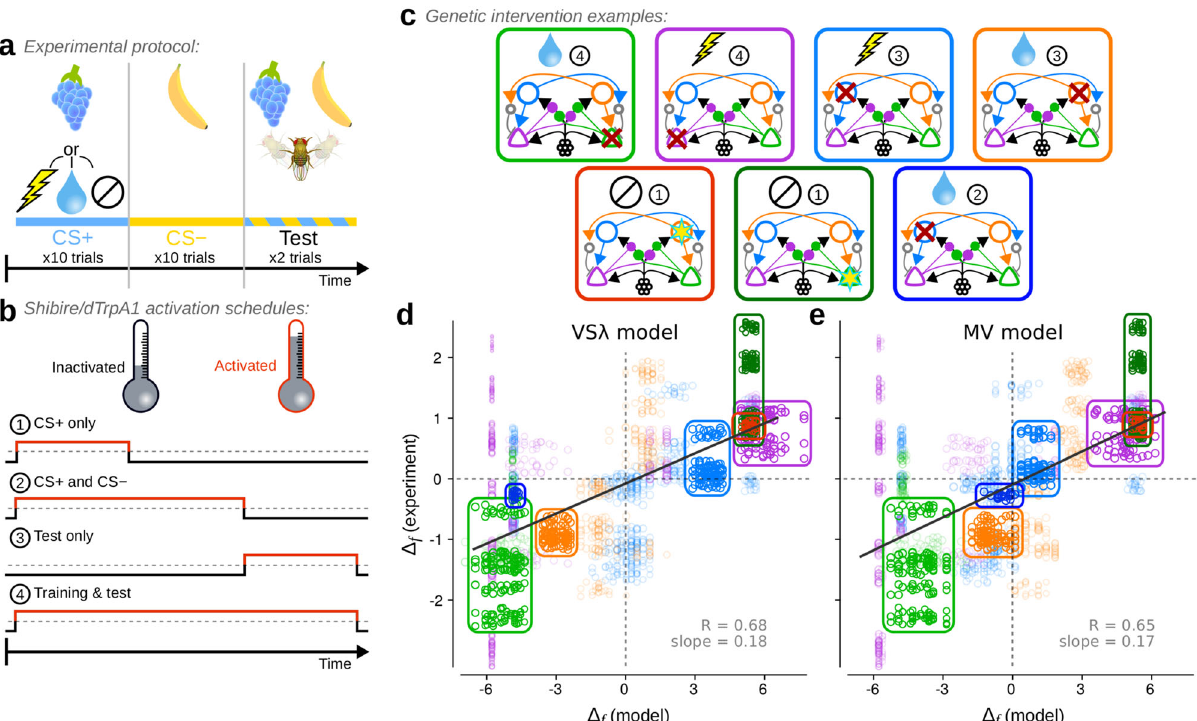
Fig. 5 Both the modi fi ed valence-speci fi c (VS λ ) and mixed-valence (MV) models produce choice behaviour that corresponds well with experiments under a broad range of experimental manipulations. a Schematic of the experimental protocol used to simulate appetitive, aversive and neutral conditioning experiments. b , c The protocol was extended to simulate genetic interventions used in experiments. b Interventions were applied at different stages of a simulation, either (1) during CS + exposure in training, (2) during CS + and CS − exposure in training, (3) during testing, or (4) throughout both training and testing. c Seven examples of the interventions simulated, each corresponding to encircled data in ( d , e ). Red crosses denote interventions that simulate activation of a shibire blockade; yellow stars denote interventions that simulate activation of an excitatory current through the dTrpA1 channel. The picture at the top of each panel denotes the reinforcement type, and the encircled number the activation schedule as speci fi ed in ( b ). d Comparison of Δ f measured from the VS λ model and from experiments. e Comparison of Δ f measured from the MV model and from experiments. Solid grey lines in ( d , e ) are weighted least square linear fi ts with correlation coef fi cients R = 0.68 (0.64, 0.73) and R = 0.65 (0.60, 0.69) respectively ( p < 10 − 4 for both models using a permutation test; 95% con fi dence intervals in parentheses using bootstrapping; n = 92). Each data point corresponds to a single Δ f computed for a batch of 50 simulation runs, and for one pool of experiments using the same intervention from a single study. Dashed grey lines denote Δ f = 0. The size of each data point scales with its weight in the linear fi t. Source data are provided in the Supplementary Data 1 fi